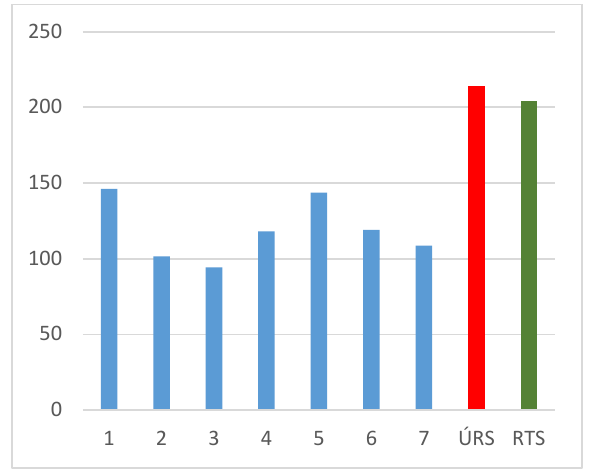
Figure 4: Comparison of project TEI EA , ÚRS and RTS indicators [EUR/m 3